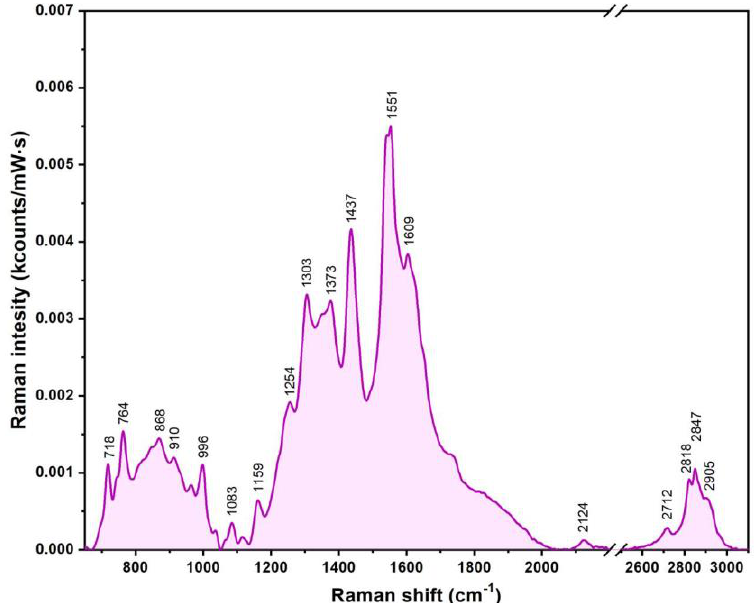
Figure 9. A typical SER spectrum of the fully decorated plasmonic magneto-liposomes recorded in liquid conditions using a 785 nm excitation.